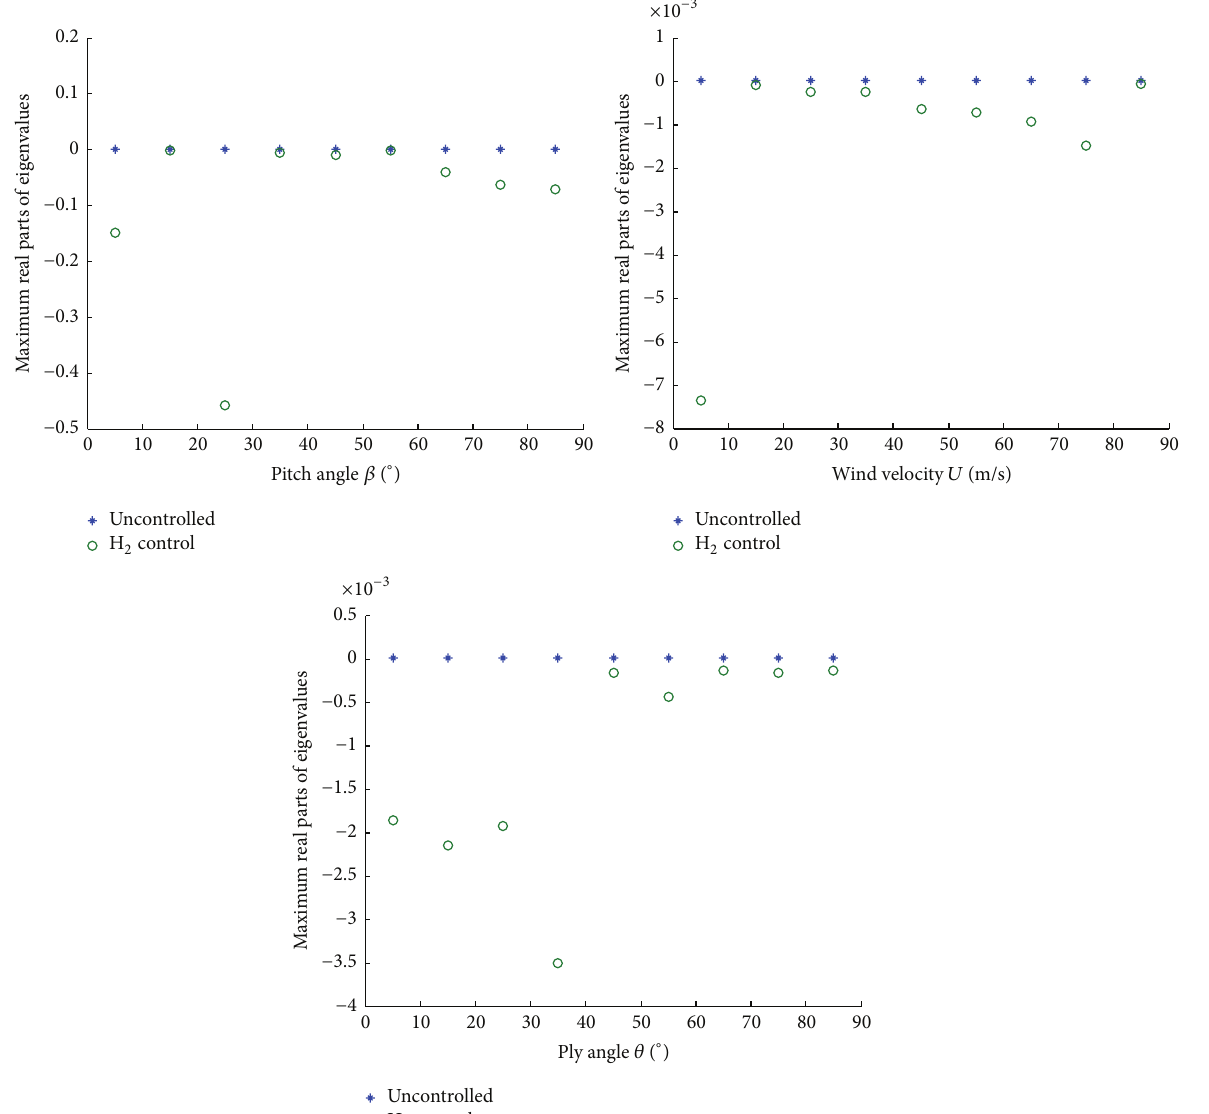
Figure 7: The maximum values of all the real parts of eigenvalues in different pitch angles, different wind velocities, and different ply angles.